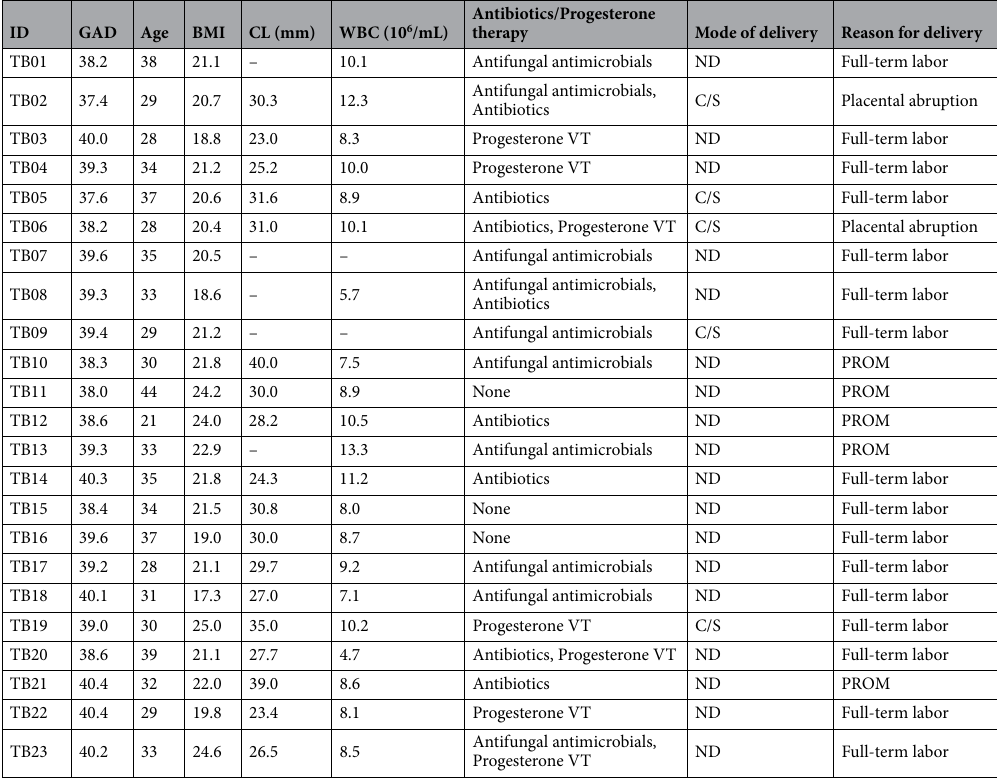
Table 2. Characteristics of the participants in the cohort study. BMI Body-mass index, CL Cervical length, VT Vaginal tablet, PROM Premature rupture of